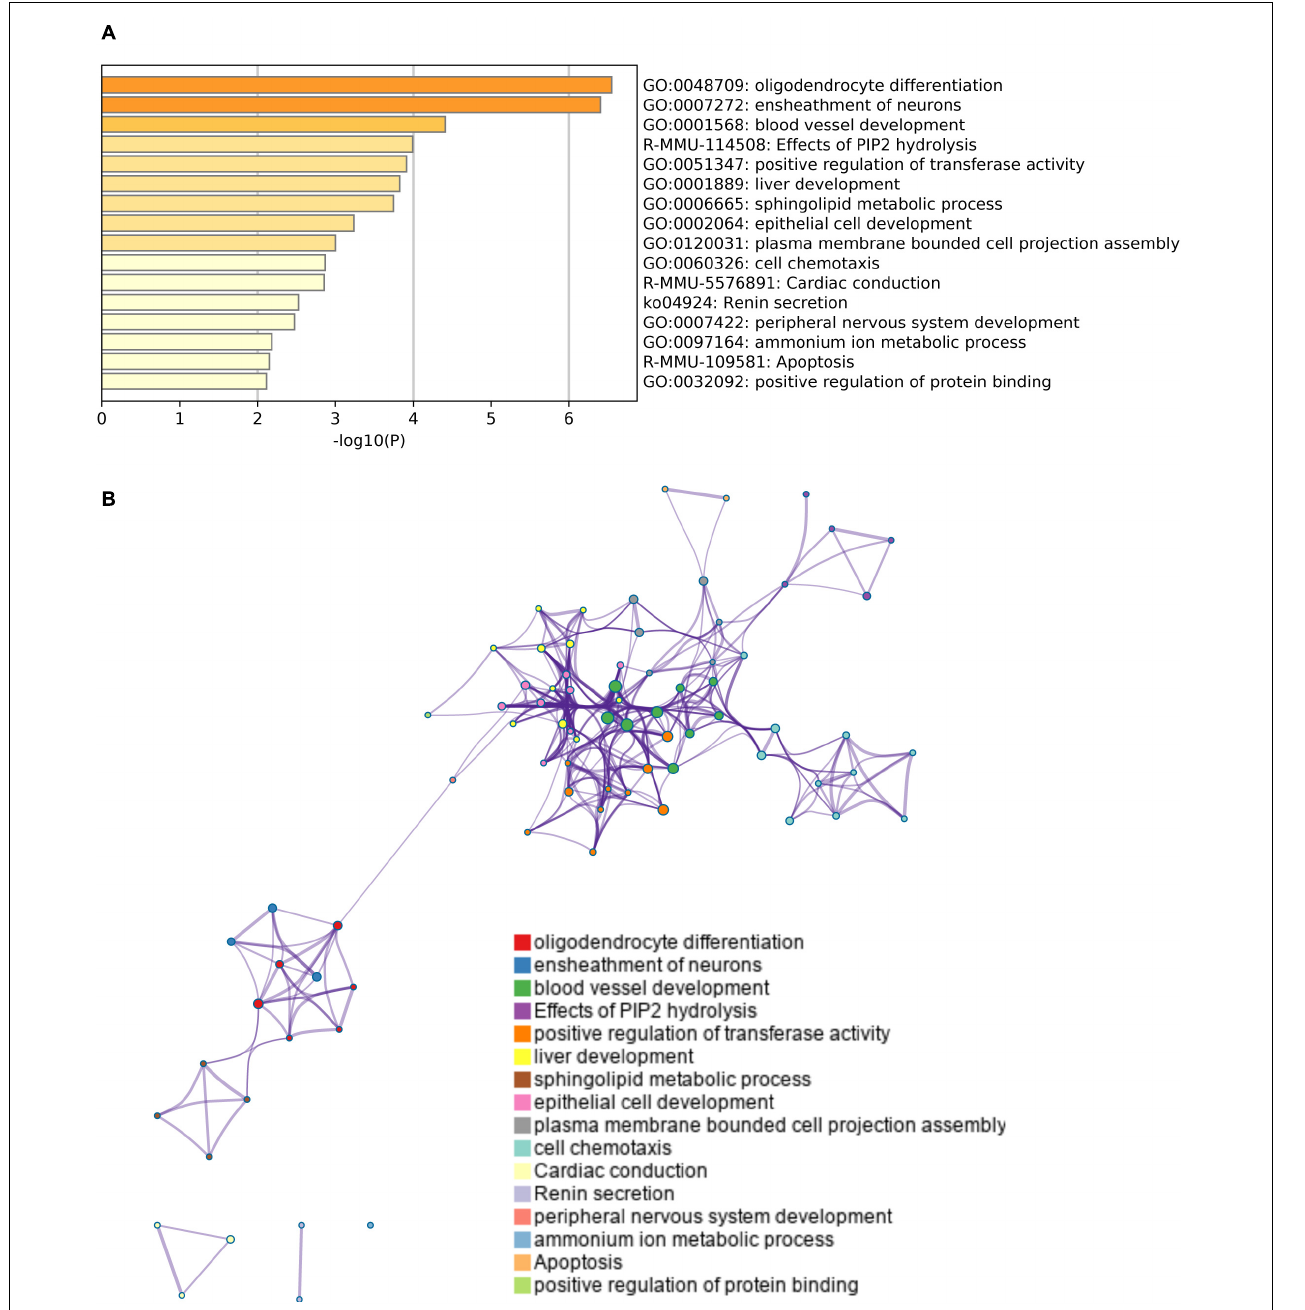
FIGURE 3 | Gene set enrichment analysis of upregulated genes. (A) A heatmap of enriched terms across the input genes list. Darker colors indicate smaller p values. Upregulated genes were related to the pathways for oligodendrogenesis (GO: 0048709 and GO: 0007272) and angiogenesis (GO: 0001568). Please see Supplementary Table 3 for the list of enriched terms of upregulated genes. (B) Metascape enrichment analysis confirms the close relationship between GO: 0048709 (oligodendrocyte differentiation) and GO: 0007272 (ensheathment of neurons). Clustering was made based on similarity (similarity >